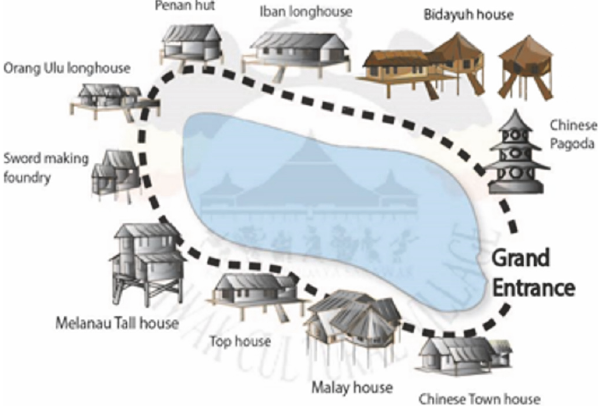
Figure 6: Map of SCV (location of each ethnic